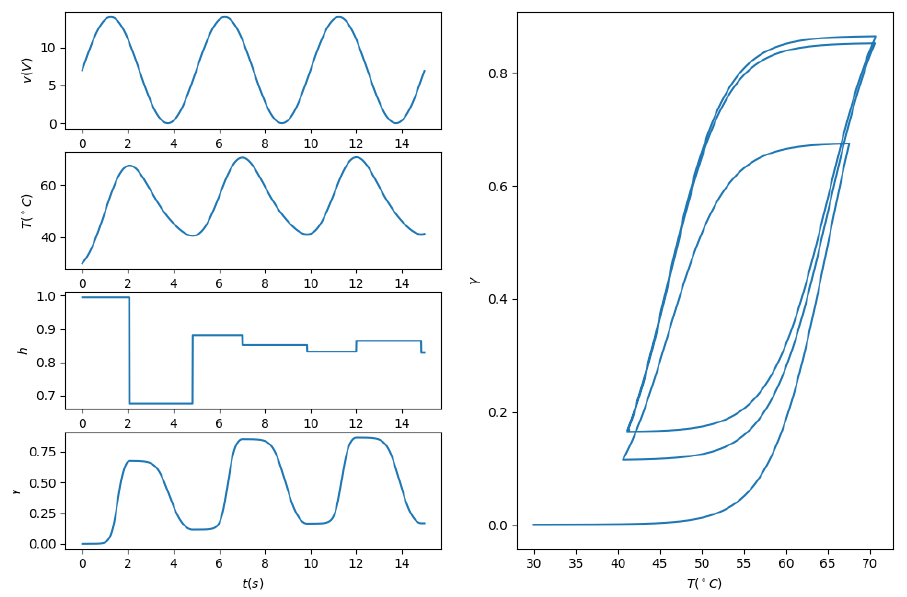
Figure 3. An illustration on the dynamics of SMA wires with sinusoidal voltage